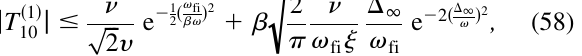
j vs 1 =(cid:9) for different functional forms of (cid:2) ð x Þ FIG. 9. j T ð 1 Þ top 10 decays as with (cid:2) 1 ¼ 2 : 5 ! . For (cid:9) > (cid:9) 1 , the matrix element T ð 1 Þ fi a Gaussian in 1 =(cid:9) . This Gaussian asymptotics is depicted by the dashed black line. For (cid:9) < (cid:9) 1 , the matrix element becomes nonuniversal. As examples, we consider the gap functions shown in the inset. The solid blue line in the main panel corresponds to domain walls with an abrupt switch from linear to constant behavior, cf. Eq. (58). The red curve shows numerical results ð x Þ for a Fermi-function–like form of (cid:2) top